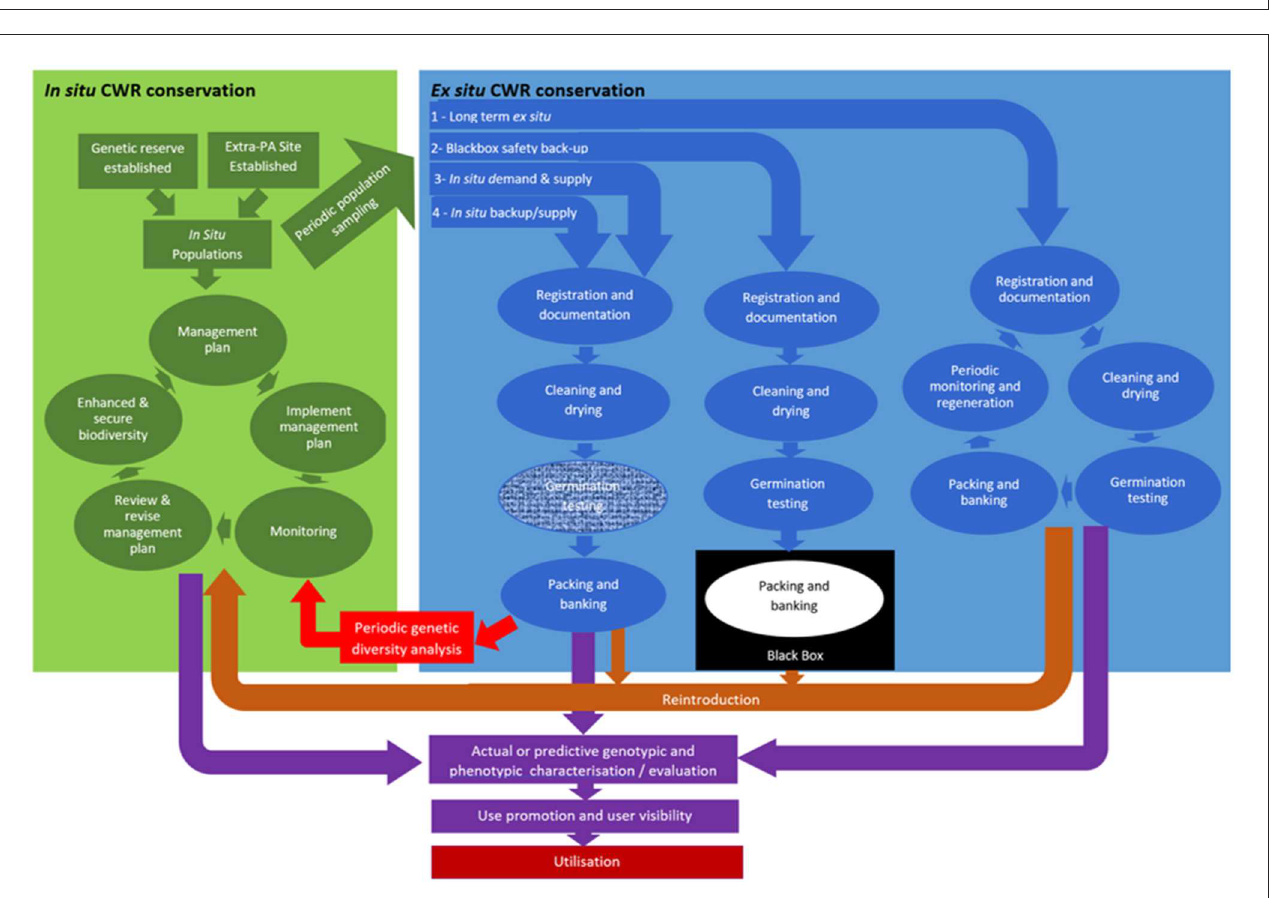
FIGURE6 In situ population linkage to